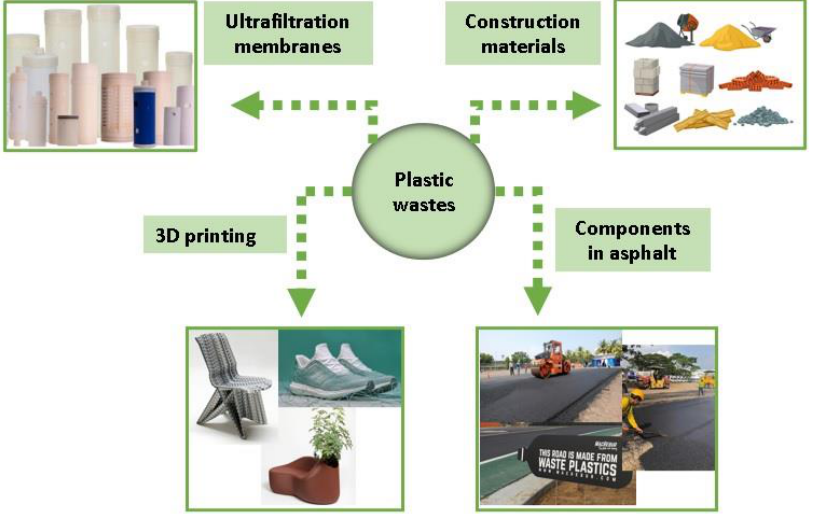
Figure 3. Possibilities of applying plastic waste towards products of added value and industrial